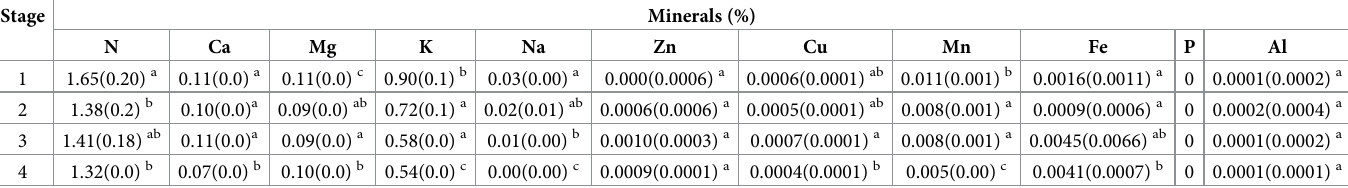
Table 3. Mineral composition of S . madagascariensis seeds at four stages of ripeness. The means for each parameter are reported under the respective stages of matu- rity followed by the standard error in brackets. Means accompanied by the same letter in a given column are not significantly different (P > 0.05). This information is based on seeds collected from location 1: